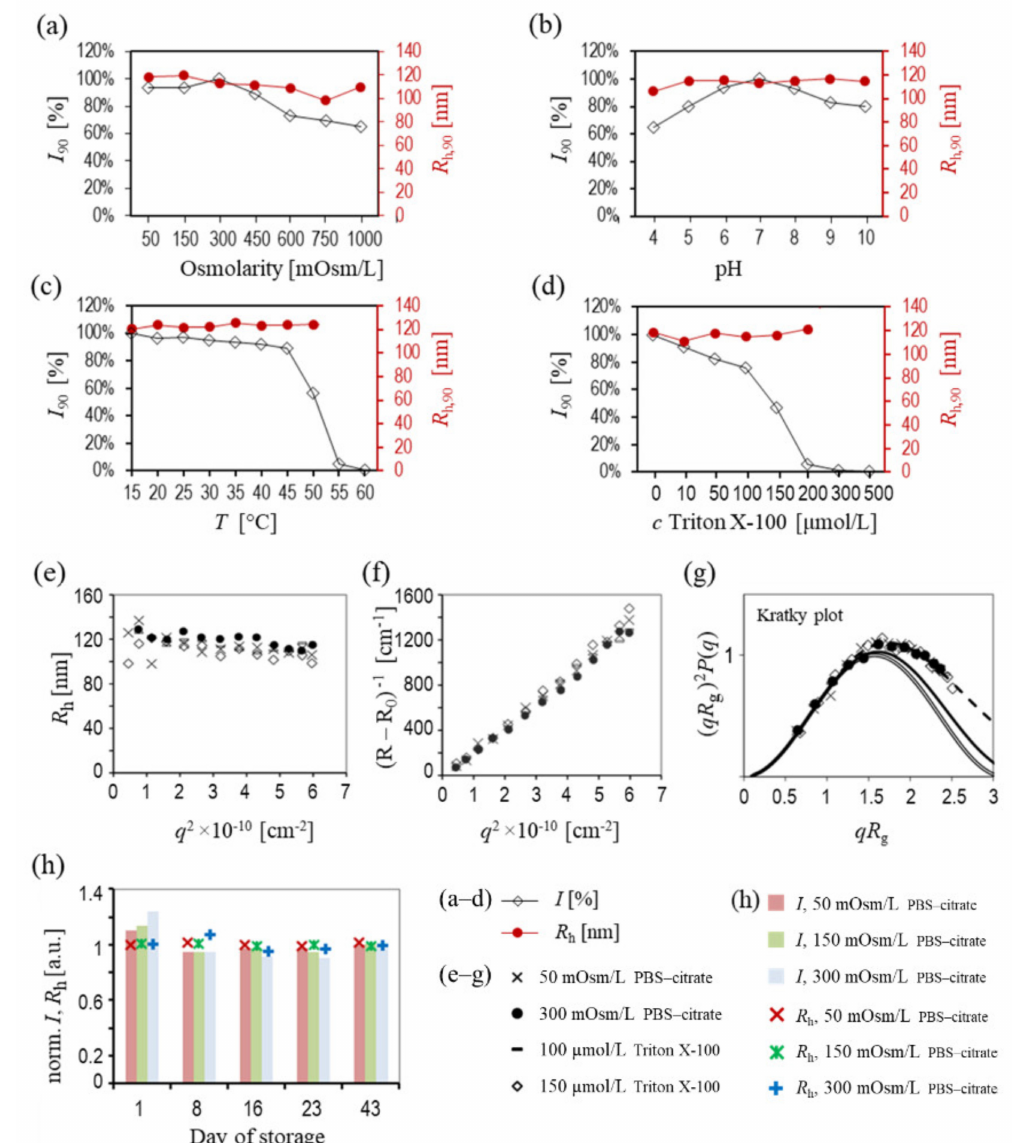
Figure 3. LS analysis of hbEV samples considering different osmolarities, pH values and temperatures, and different concentrations of added Triton X-100. The normalized intensity of the light scattered from the hbEVs suspension I measured at 90 ◦ ( I 90 , primary axis, empty black squares) and the mean hydrodynamic radius R h measured at 90 ◦ ( R h , 90 secondary axis, red circles) obtained from the correlation function G 2 ( t ) are depicted for: ( a )—different medium osmolarities, ( b )—different pH values of the suspension, ( c )—different temperatures of the suspension, ( d )—different concentrations of the added Triton X-100. In a–d, I was normalized to the respective value of the starting sample (a: osmolarity of the medium = 300 mOsm/L, b: pH = 7, c: T = 15 ◦ C, d: c TritonX-100 = 0, respectively). The points are connected to facilitate the tracking of the results. Multiangle analysis of the light scattered on hbEVs at different media osmolarities and with the addition of different concentrations of Triton X-100 is shown in ( e ): angular dependence of R h , ( f ): angular dependence of the reciprocal intensity of the scattered light (R − R 0 ) − 1 , and ( g ): the Kratky plot representation (dependence of ( qR g ) 2 P ( q ) on qR g ) of the measured data. The curves corresponding to the theoretical structure factor ρ pertaining to the filled sphere (full line) and to the hollow sphere (double line) and the Guinier function (dashed line) are also depicted in Panel g. In ( e – g )—circles: 300 mOsm/L, crosses: 50 mOsm/L, dashes: 100 µ mol/L, diamonds: 150 µ mol/L of added Triton X-100; h: I 90 (boxes) and R h,90 (markings) pertaining to hbEVs suspended in media with different osmolarites assessed on days 1, 8, 16, 23, and 43 after isolation from an aged erythrocyte suspension that had been aged in vitro. I 90 and R h,90 in Panel ( h ) are presented as normalised to the average values of the respective measurements over time. a. u.—arbitrary units. Red—50 mOsm/L, green—150 mOsm/L, blue—300